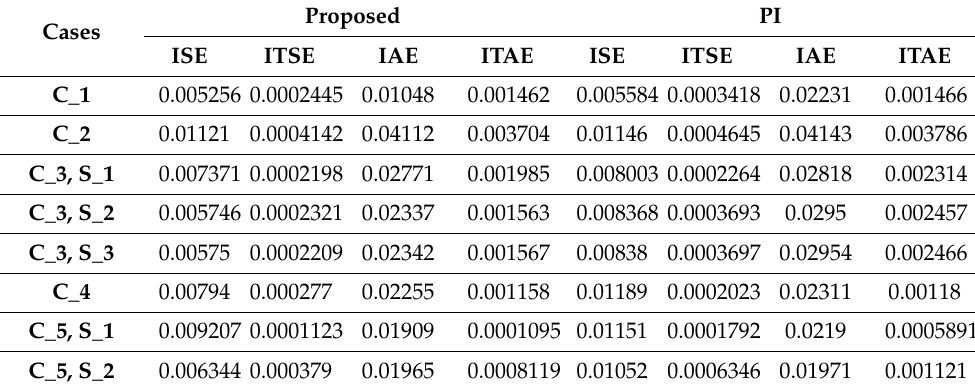
Table 2. Control performances under unbalanced grid conditions. C—Case,